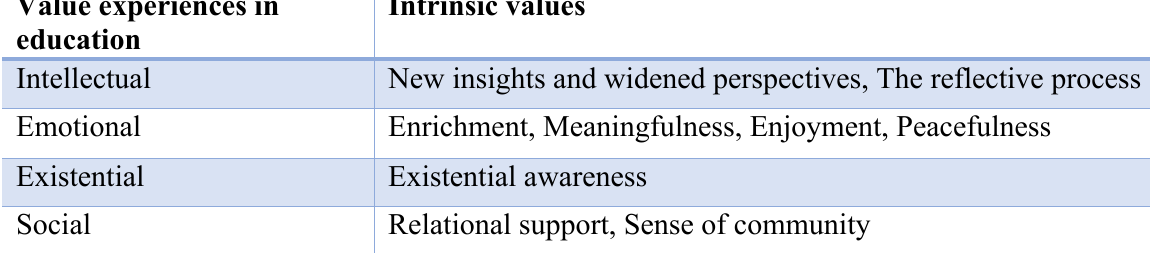
Table 2. The distribution of intrinsic values in the themes of value